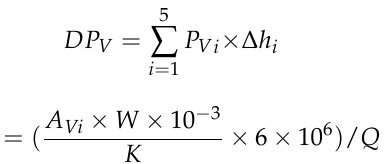
Figure 3. The deposition collection system.